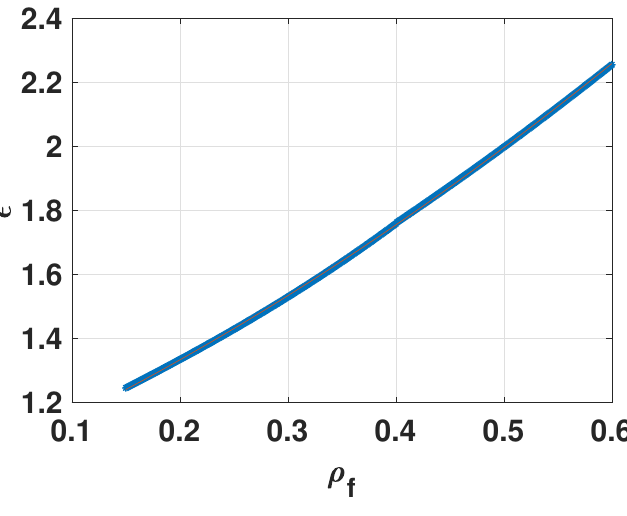
Figure 10. Snow permittivity vs. snow